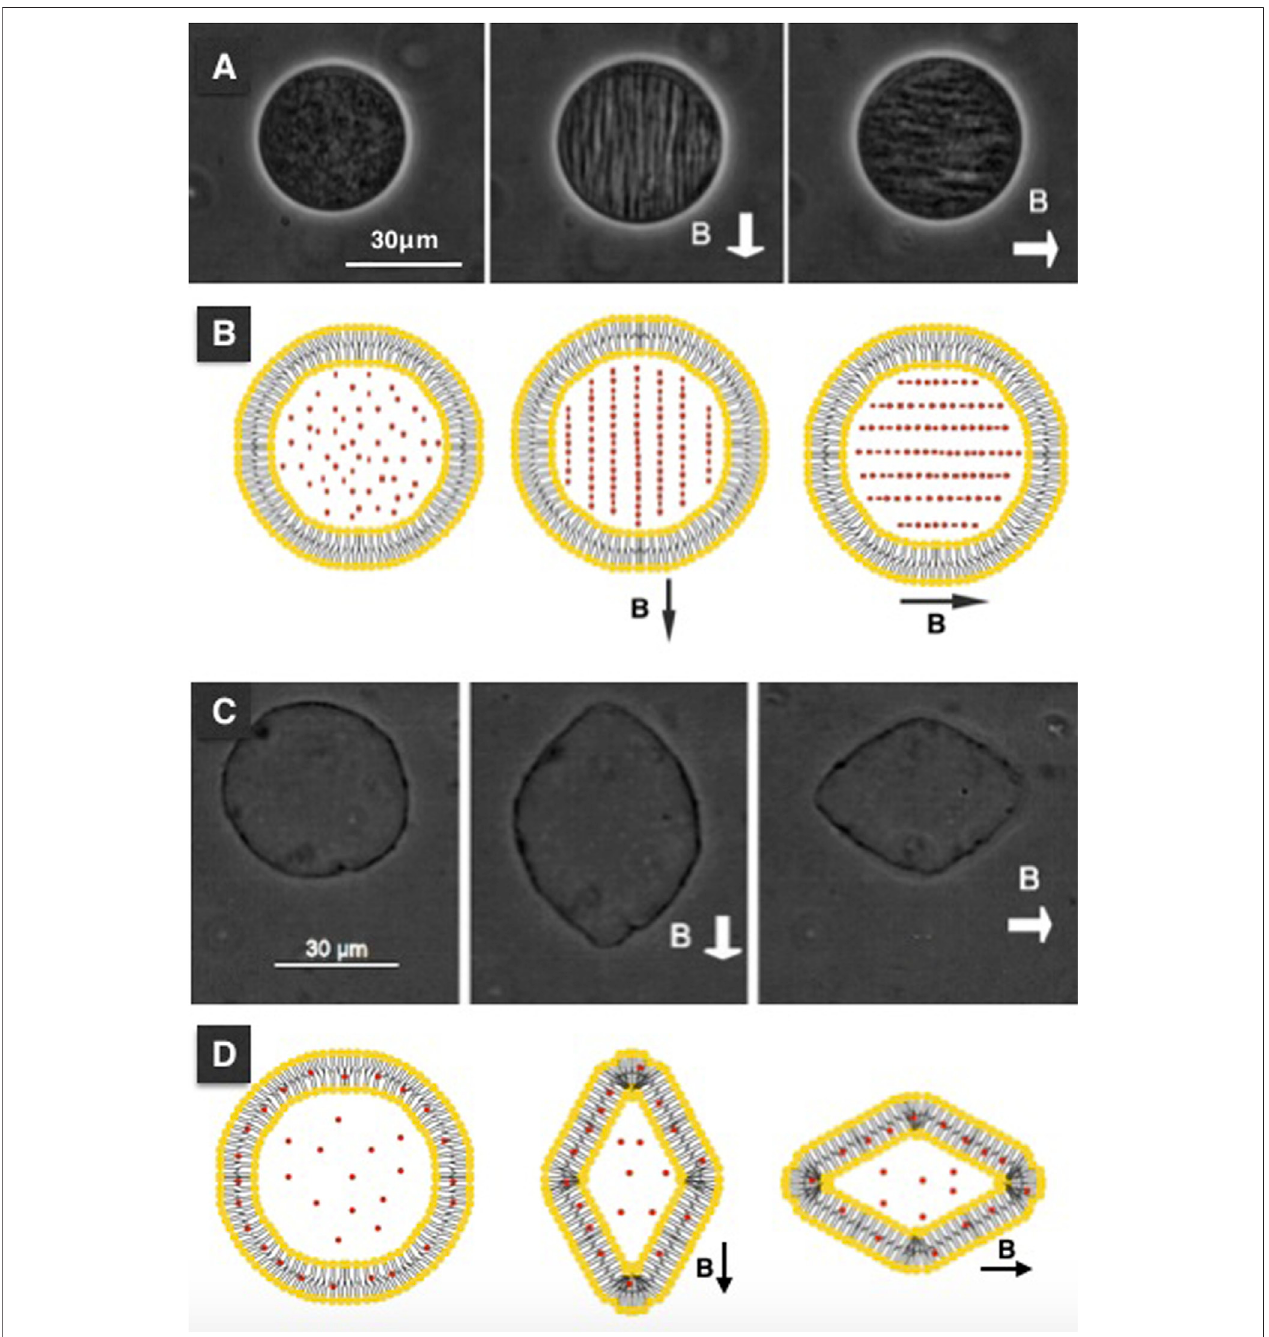
FIGURE4| Chainformationsand magnetodeformationwithencapsulated SNPs.Chain formationofSNPs take place intheinner medium oftheMLs,and inother cases they deform in the direction of the DC magnetic fi eld applied. (A) shows the MLs when no fi eld is applied, next image when a DC magnetic fi eld is applied. (B) is a cartoon representation to illustrate the SNPs are forming chains. When rehydration takes place (in this case SNPs concentration is at 1 % ), MLs with the excess area is observed, see (C) . When a DC magnetic fi eld is applied, this type of MLs deforms in the direction of the DC magnetic fi eld. If the direction of the magnetic fi eld is rotated by π /2, the deformation takes place in the same direction as the direction of the magnetic fi eld. (D) is a cartoon representation of the interaction between SNPs and lipids of the MLs. The intensity of the DC magnetic fi eld was 0.09 T for the case of chain formation and 0.025 T for the ML deformation.